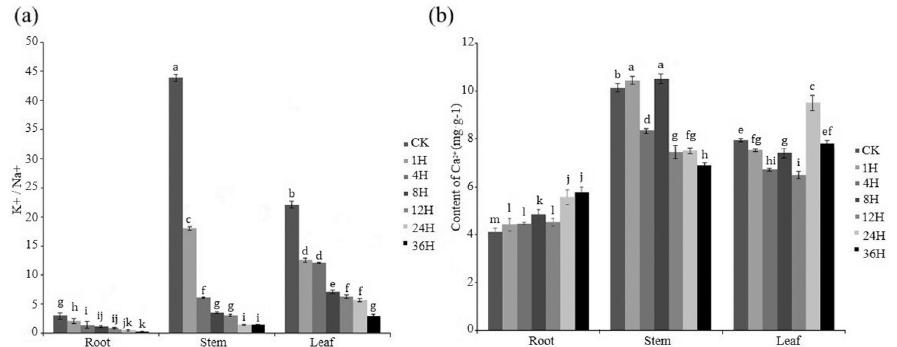
Fig 6. Effect of salt stress (250 mM NaCl) on the K+/Na+ ratio and calcium ion content in leaves, stem, and roots of grape (Vitis vinifera). (a) K+/Na+ ratio in leaves, stem and roots. (b) Ca2+content in leaves, stems, and roots. To visualize the relative expression levels data are presented as the mean fold changes between treated and control samples at each time point ± standard deviations (SDs).